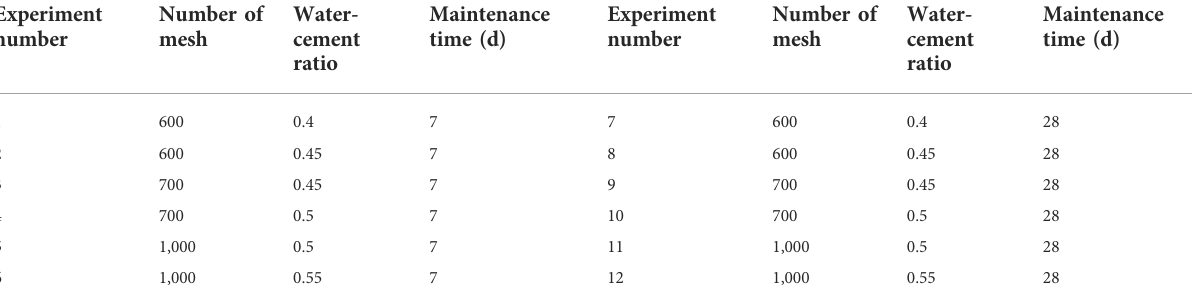
TABLE 8 Proportioning scheme of super fi ne cement